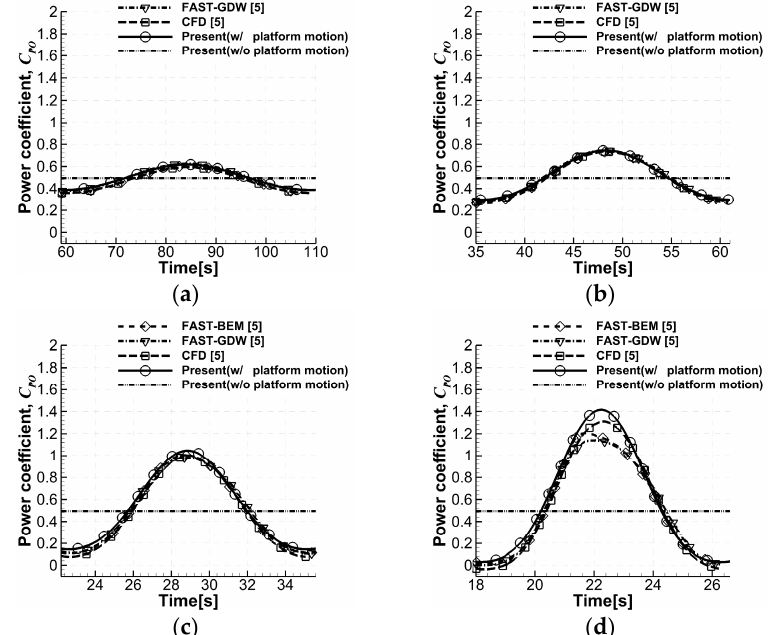
Figure 6. Comparison of rotor power coefficient with other numerical predictions. ( a ) Case 1, ( b ) Case 2, ( c ) Case 3, and ( d ) Case 4.